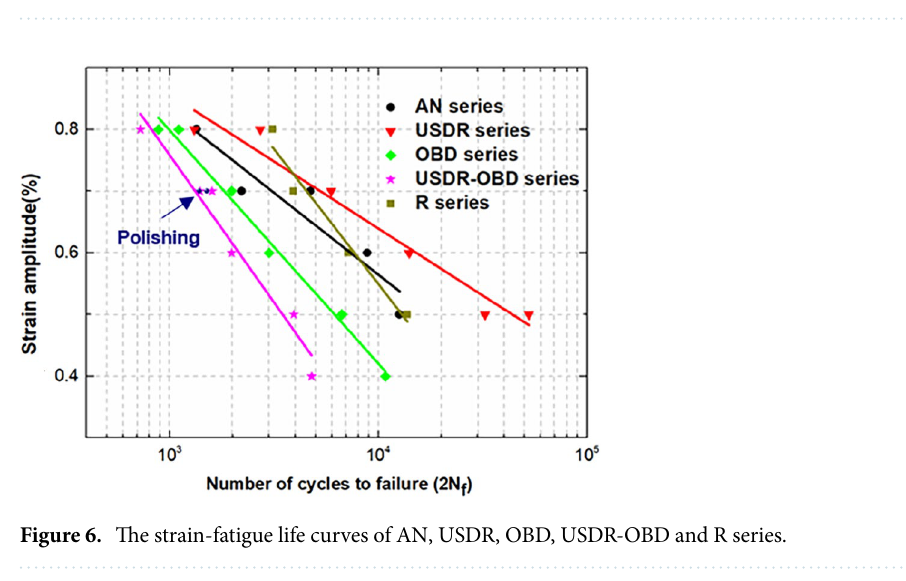
Figure 5. Residual stress distribution of AN series, USDR series, OBD series and USDR-OBD series.